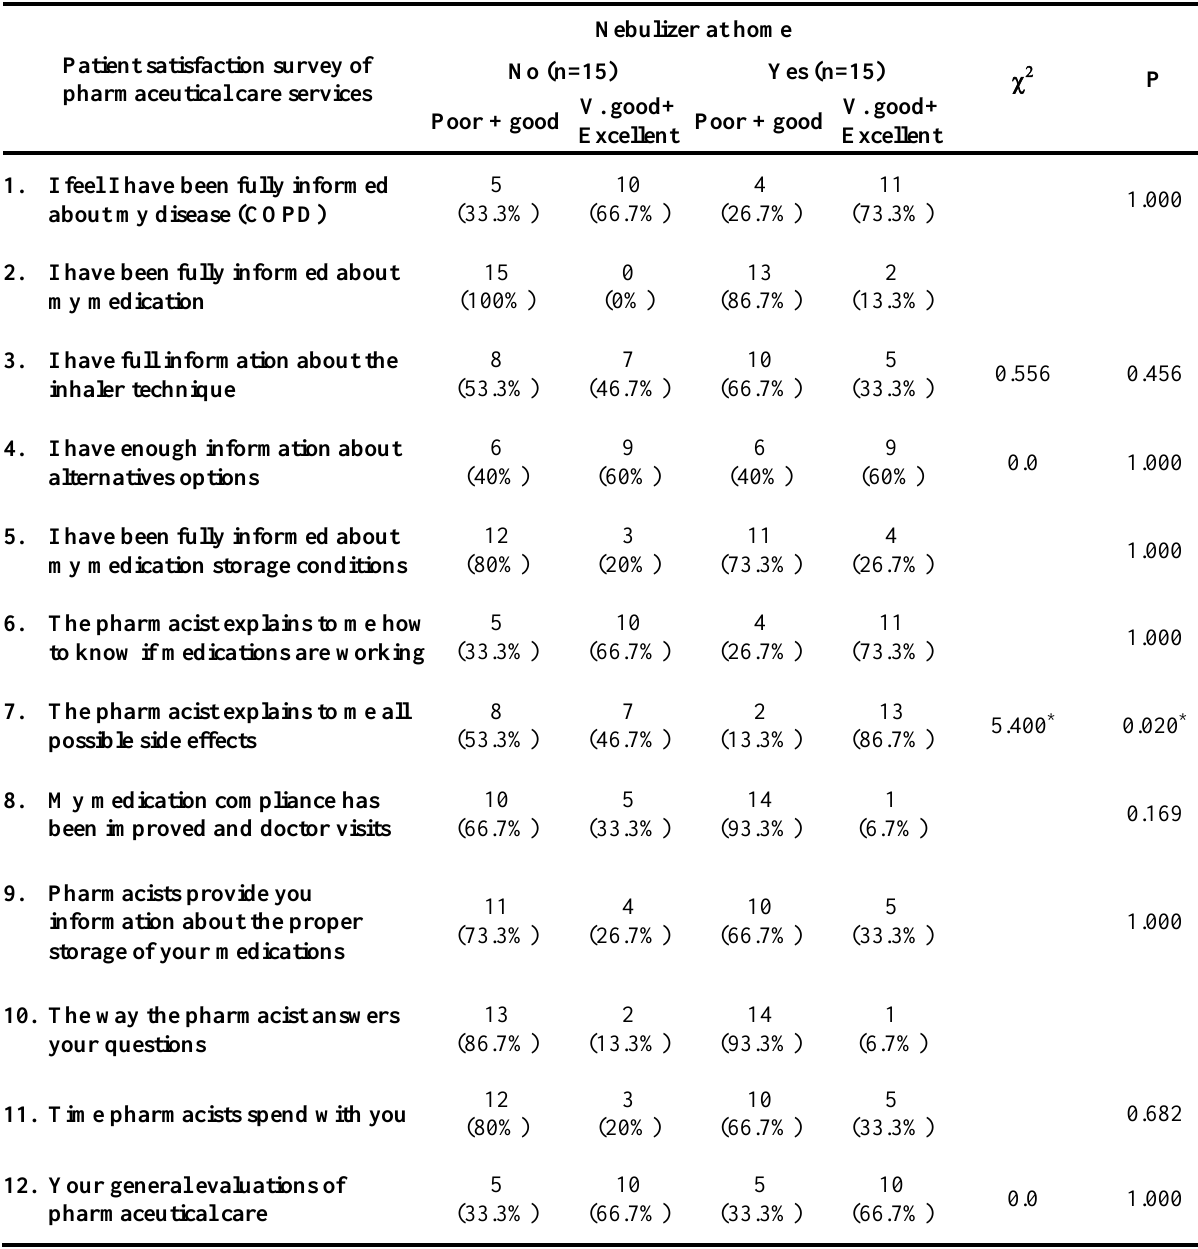
Table 3. Relation between nebulizer at home and patient satisfaction survey of pharmaceutical care services